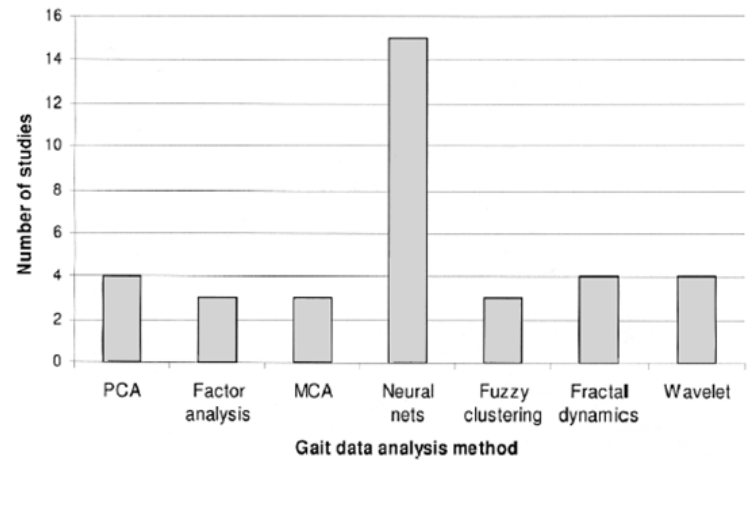
Figure 11. Algorithmic techniques for gait